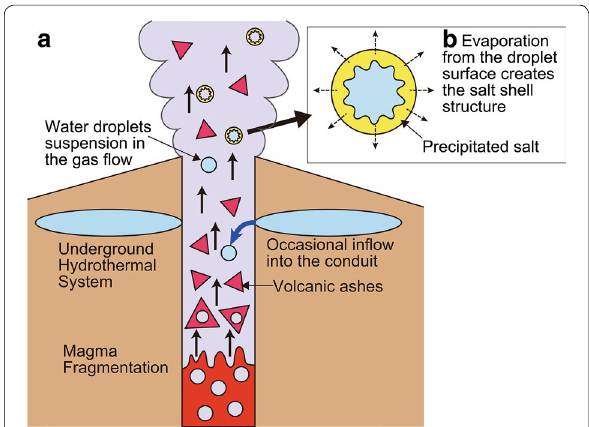
Fig. 3 A schematic diagram of the formation process of salt fallouts. a A hydrothermal solution distributed beneath the crater floor surrounding the eruption vent. The hydrothermal solution sporadi- cally pours into the conduit of the eruption plume or the gas plume, beneath the vent. b The poured solution forms droplets and is then transported by the plume. Heating of the droplet in the plume evaporates the water, precipitating the salts at the droplet surface. A complete drying of the droplet creates a hollow spherical salt shell. Preservation of the fragile, hollow spherical salt shell structure during transport suggests that the salt formation occurs after magma frag- mentation, implying that the hydrothermal solution layer is located at a depth shallower than the magma fragmentation